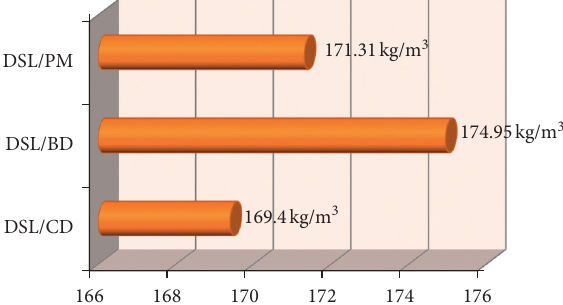
Figure 2: RDs of the briquettes with different